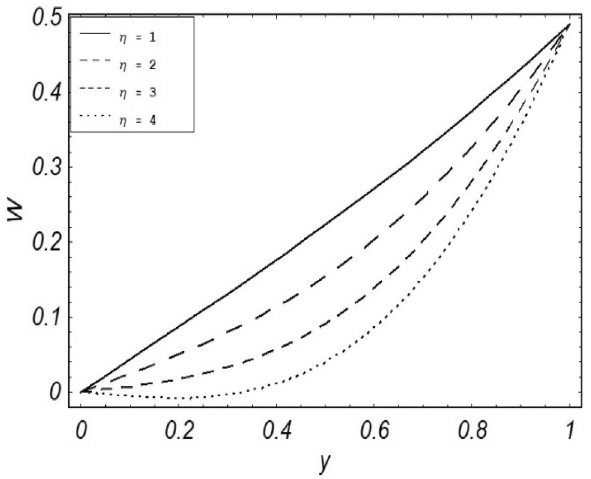
Figure 13. Evolution of W with various values of η if t = 1 ; M = 2.5 ; K 1 = 0.5 ; N = 1 ; Gr = 0.2 ; m = 0.5 ; � = 0.5 ; Re = 1 ; α = 0.1 ; ω = 0.5 ; ε = 0.001 .